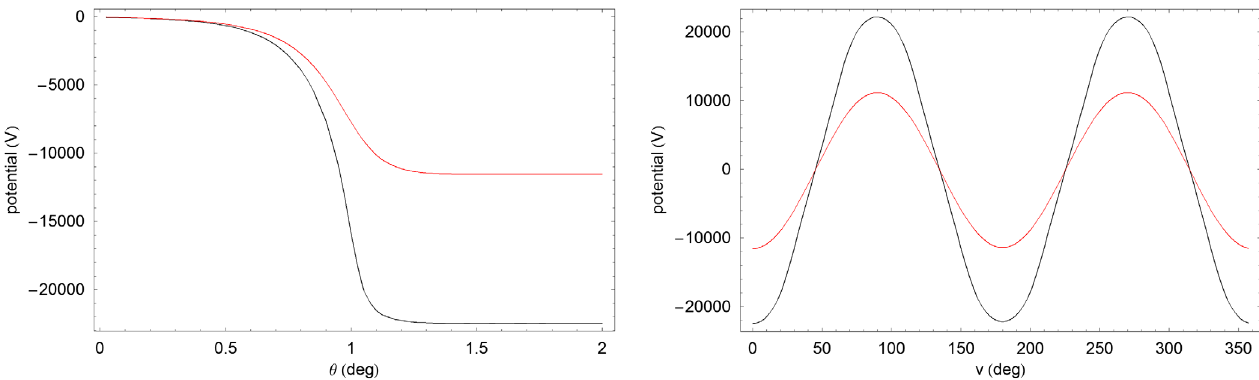
FIG. 10. Scalar potential in an electrostatic quadrupole in the g − 2 storage ring. The potential is plotted as a function of toroidal coordinate θ at v ¼ 0 (left) and as a function of v at θ ¼ 2 ° (right). In each plot, the black line shows the potential at u ¼ u the red line shows the potential at u ¼ 6 . 11 . At the larger value of u , the value of the coordinate x is reduced by a factor of to the value of x at u ¼ u ; the potential is a factor of 2 smaller at the larger value of u , as expected for a quadrupole ref